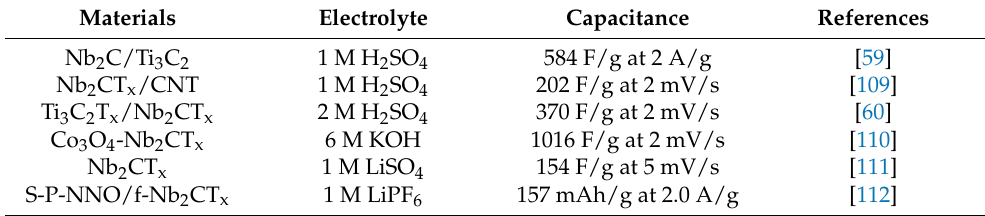
Table 3. The specific capacities of Nb 2 CT x for